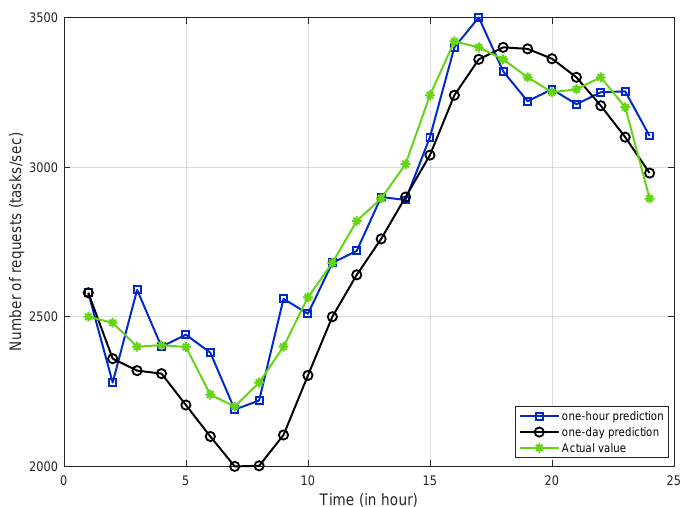
Figure 4. Total task processing requests based on actual, one-hour and one-day prediction.